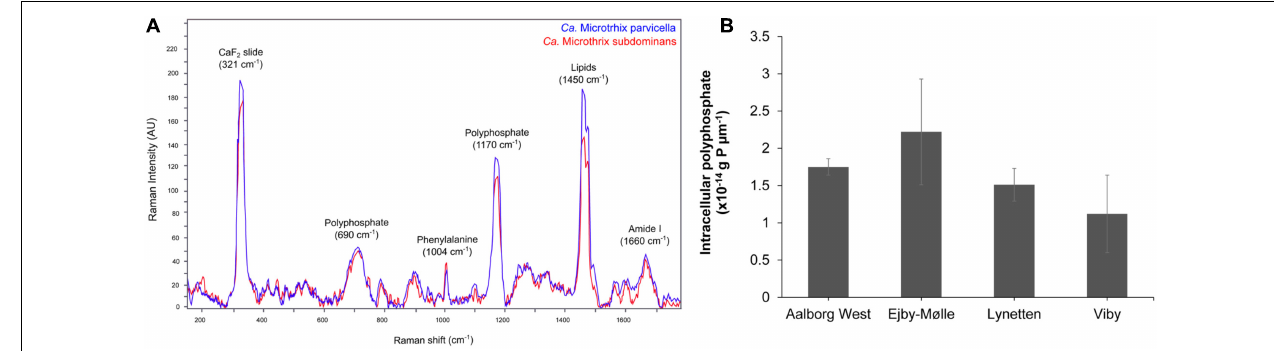
FIGURE 6 | FISH-Raman analysis of Ca. Microthrix filaments. (A) Raman spectra showing the presence of poly-P as well as lipidic compound in both Ca. Microthrix species, (B) quantification of poly-P content in Ca. Microthrix filaments (at the genus-level) in activated sludge sampled from a full-scale plant aeration tank (adapted from Petriglieri et al.,